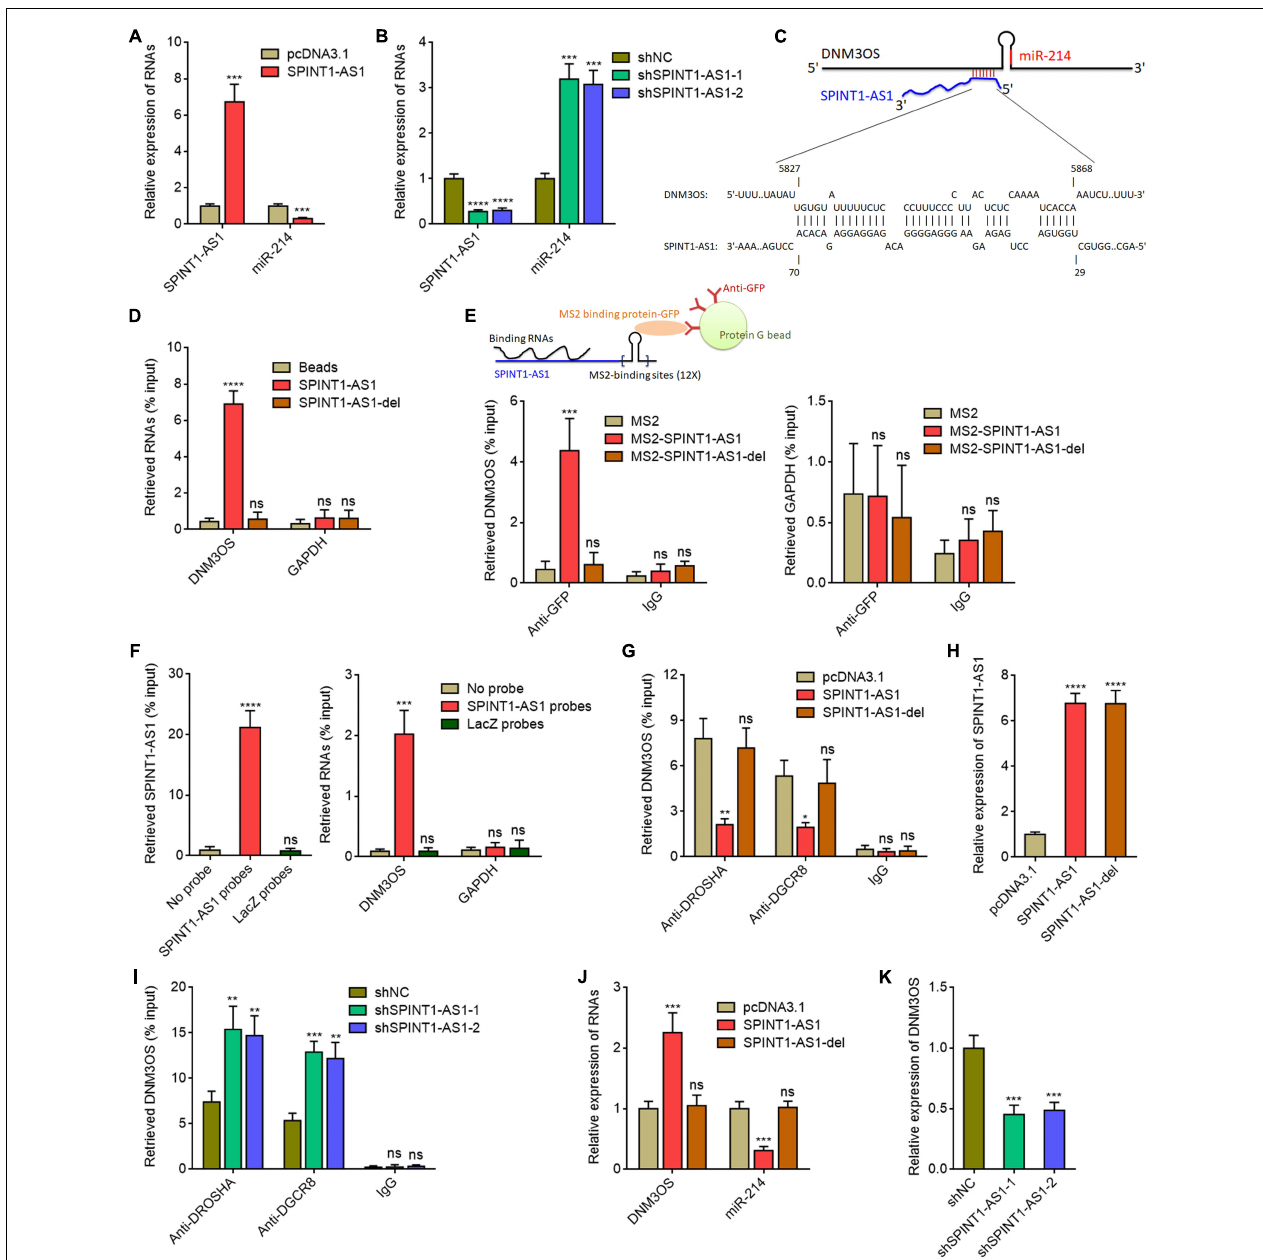
FIGURE 2 | SPINT1-AS1 repressed miR-214 biogenesis via binding DNM3OS. (A) SPINT1-AS1 and miR-214 expressions in HeLa cells with SPINT1-AS1 stable overexpression were detected by qRT-PCR. (B) SPINT1-AS1 and miR-214 expressions in HeLa cells with SPINT1-AS1 stable silencing were detected by qRT-PCR. (C) Schematic diagram of the predicted interaction between DNM3OS and SPINT1-AS1. (D) RNA affinity pulldown assays using in vitro transcribed biotinylated SPINT1-AS1 or 5 (cid:48) 70 nucleotides deleted SPINT1-AS1 (SPINT1-AS1-del) were conducted to retrieve the RNAs interacted with SPINT1-AS1. The retrieved RNAs were detected by qRT-PCR. (E) MS2 vector-based RIP assays were conducted in HeLa cells to retrieve the RNAs interacted with SPINT1-AS1. The retrieved RNAs were detected by qRT-PCR. (F) Biotinylated anti-sense oligo probes against SPINT1-AS1 were used to capture endogenous SPINT1-AS1 and the RNAs interacted with SPINT1-AS1 in HeLa cells. The retrieved RNAs were detected by qRT-PCR. (G) RIP assays using DROSHA and DGCR8 antibodies were performed in HeLa cells with SPINT1-AS1 or SPINT1-AS1-del stable overexpression. The retrieved RNA was measured by qRT-PCR. (H) SPINT1-AS1 expression in HeLa cells with SPINT1-AS1 or SPINT1-AS1-del stable overexpression was detected by qRT-PCR. (I) RIP assays using DROSHA and DGCR8 antibodies were performed in HeLa cells with SPINT1-AS1 stable silencing. (J) DNM3OS and miR-214 expressions in HeLa cells with SPINT1-AS1 or SPINT1-AS1-del stable overexpression were detected by qRT-PCR. (K) DNM3OS expression in HeLa cells with SPINT1-AS1 stable silencing was detected by qRT-PCR. Results are shown as mean ± SD based on three independent experiments. * P < 0.05, ** P < 0.01, *** P < 0.001, **** P < 0.0001, ns, not significant, by Student’s t -test (A) or one-way ANOVA followed by Dunnett’s multiple comparisons test (B,D–K)